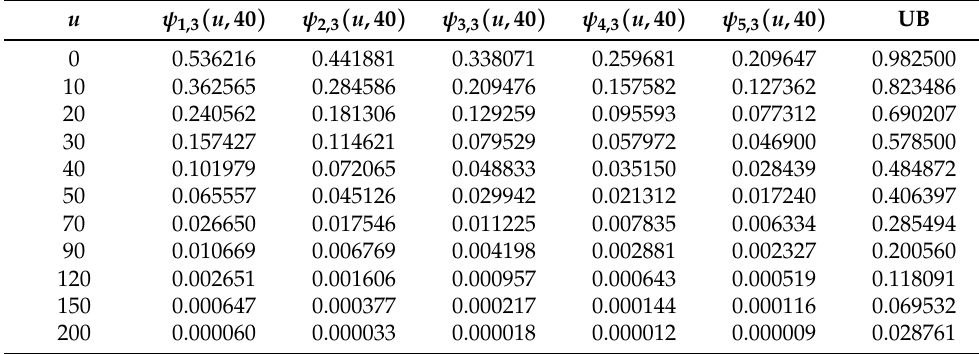
Table 4. Results for χ (cid:48)